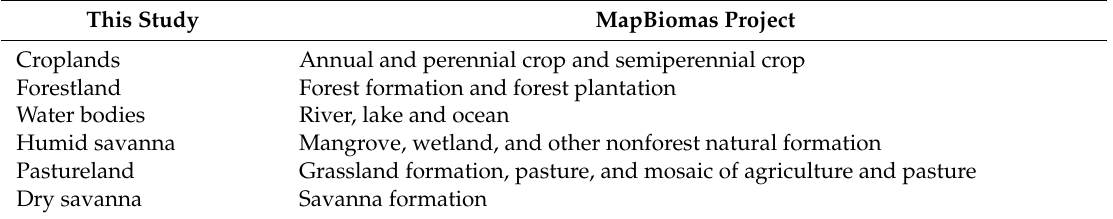
Table 1. Legend consistency between this study and the MapBiomas † land use and land cover mapping